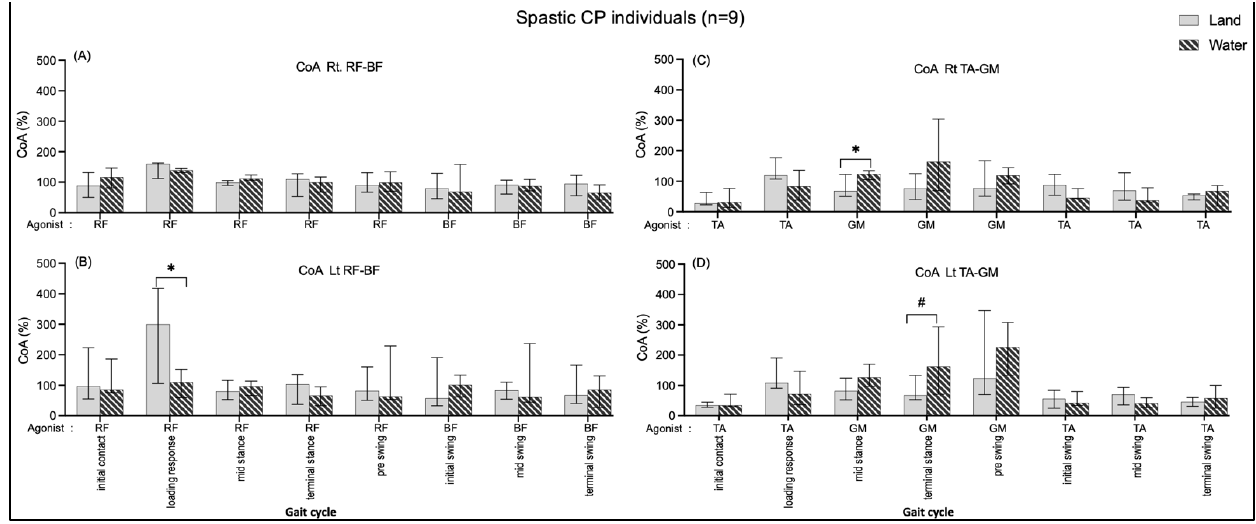
Figure 7. Co-activation index (CoA) of right RF-BF ( A ), left RF-BF ( B ), right TA-GM ( C ), and left TA-GM ( D ) during walking in water and on land in the CP individuals. * and # are significant median differences between walking on land and in water at p < 0.05 and p < 0.01.